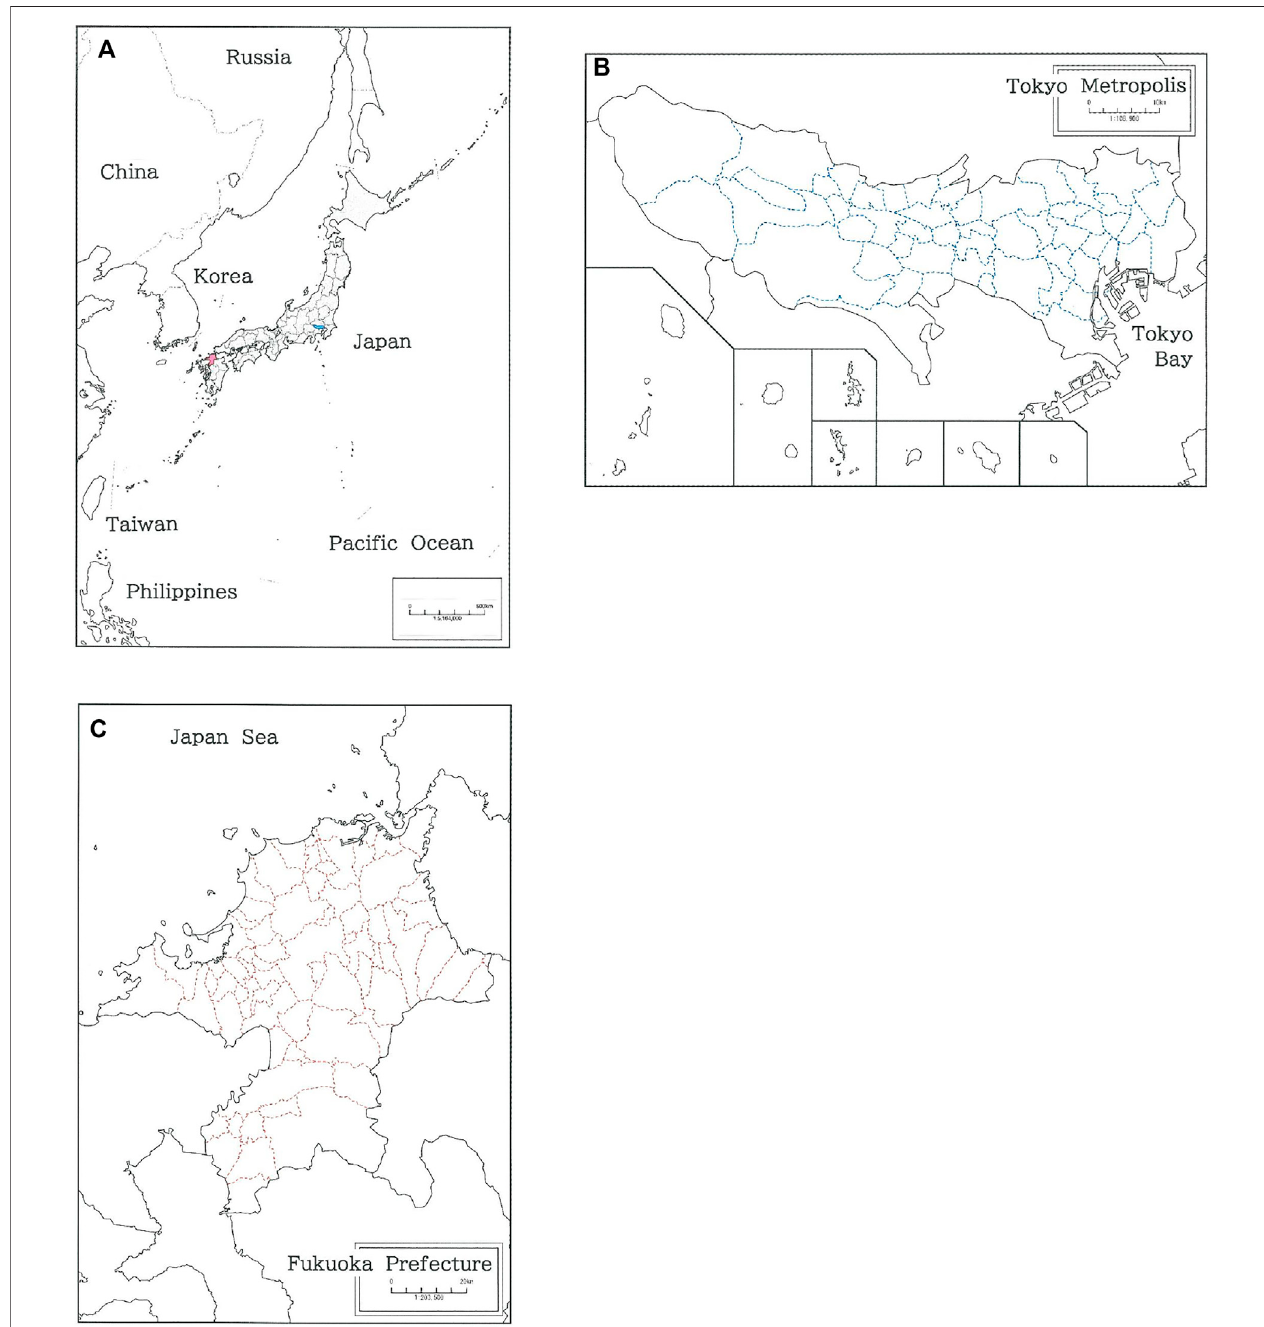
FIGURE 2 | A complete map of (A) Japan, (B) the Metropolis of Tokyo, and (C) Fukuoka Prefecture. The two prefectures are marked with the blue and red ink, respectively, in (A) . The colored dashed lines in (B, C) indicate the boundaries among municipalities in the prefecture.